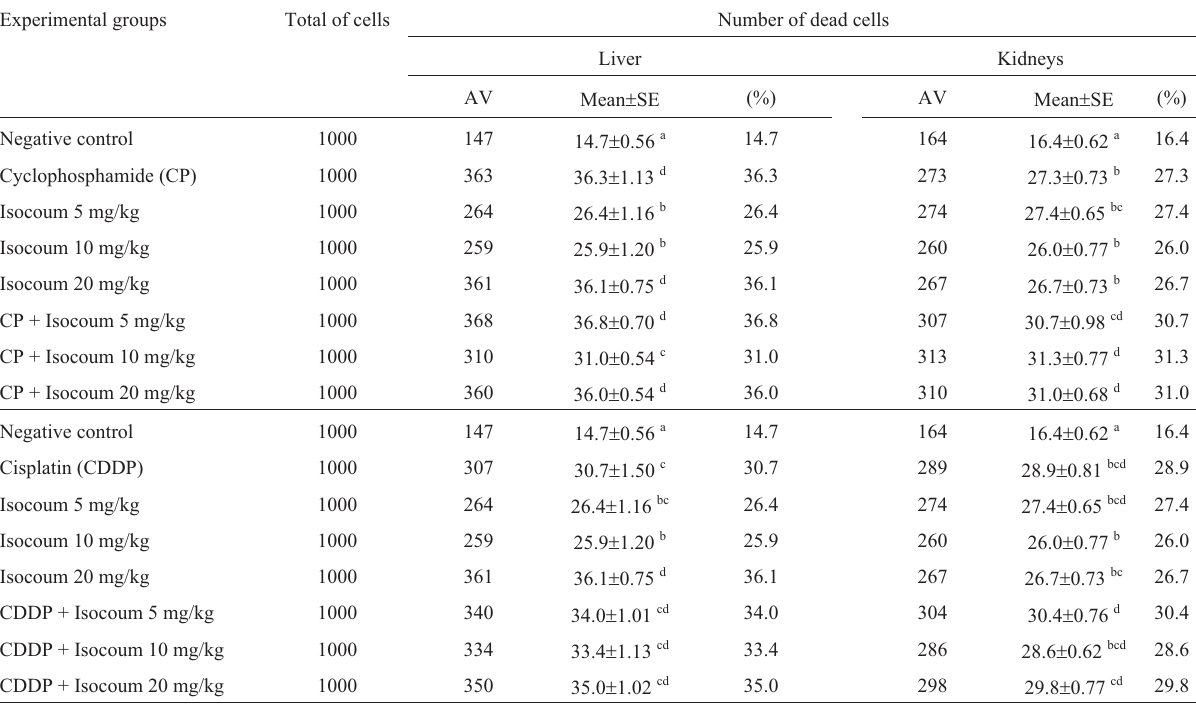
Table 4 - Absolute values (AV) and mean (cid:5) SE of dead cells in kidneys and liver of Swiss mice. Experimental